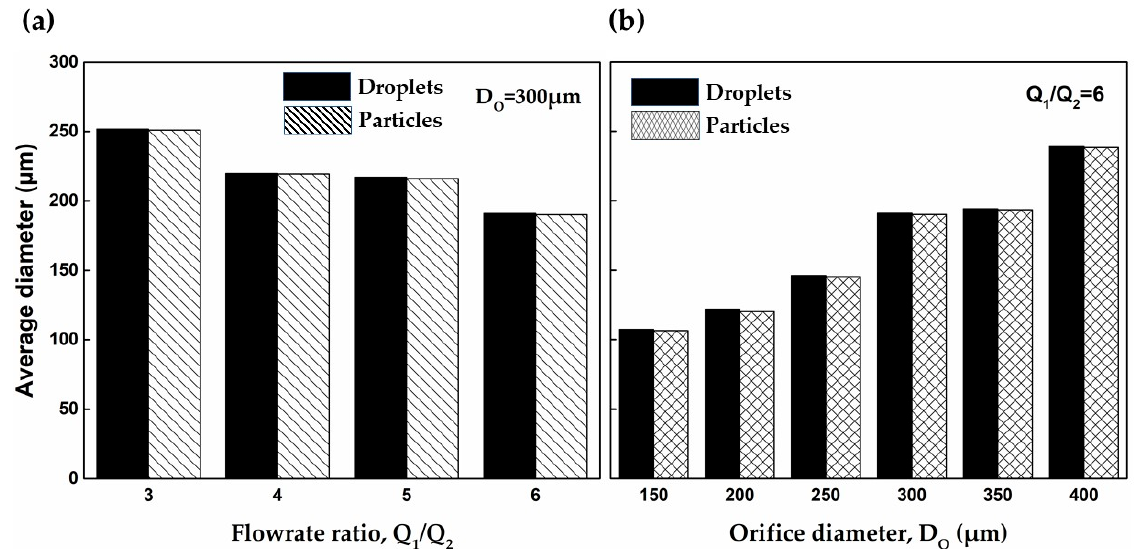
Figure 7. Comparison of the average diameter of droplets and particles: ( a ) The orifice size D o was kept constant at 300 µ m. ( b ) The flow rate ratio Q 1 / Q 2 was kept constant at 6 ( Q 1 —continuous phase flow rate, Q 2 —dispersed phase flow rate). Error bars are too small to be visible.